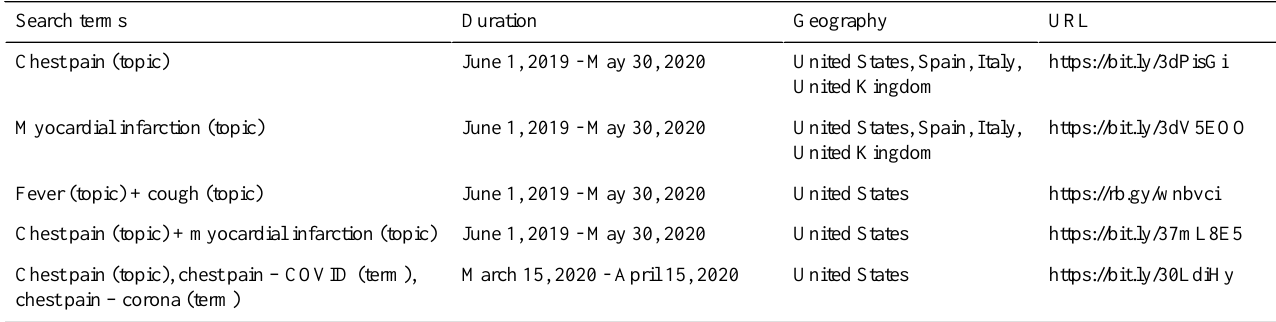
Table 1. Google Trends queries used for data